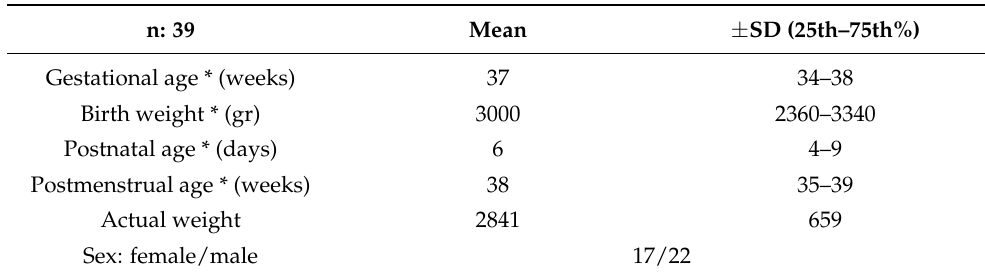
Table 1. Demographic data of the patients (values not normally distributed are given with the median, and the 25th and 75th percentiles, and marked with *).